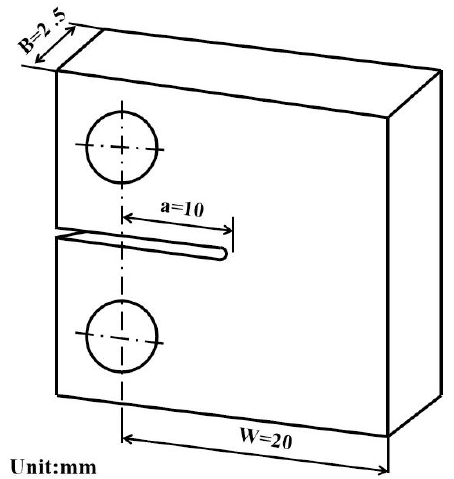
Figure 1. Geometric size of the compact tension specimen.